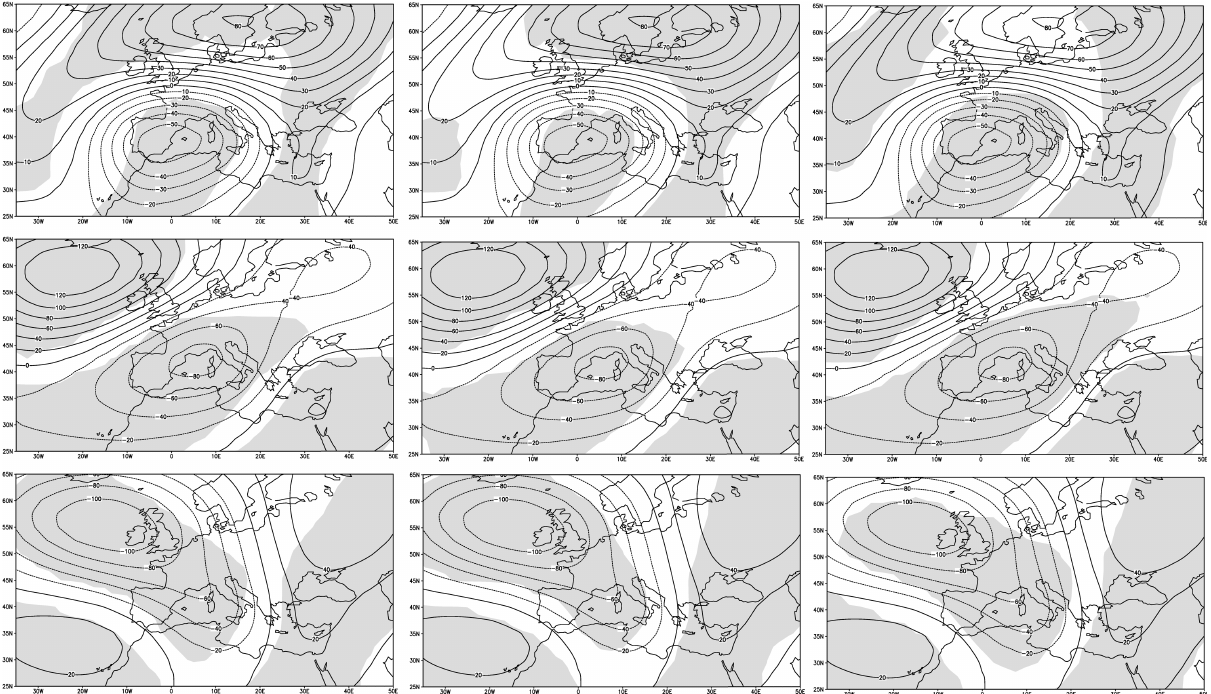
Fig. 6. Results of the Brunner-Munzel test applied to the three western Mediterranean Z500 clusters (one per row) during extreme pre- cipitation days against Z500 clusters associated with non-extreme wet days. Contour lines represent the centroids associated with extreme precipitation. The grey shadow denotes areas with significance ≥